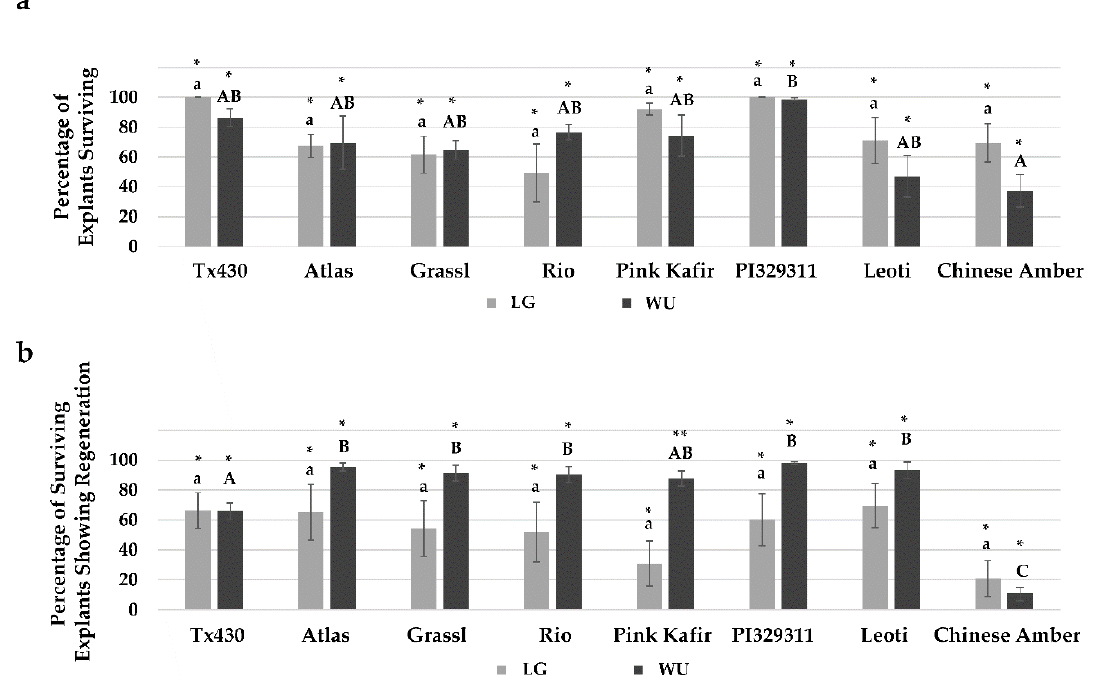
Figure 4. Impact of LG and WU protocols on overall explant response for the various genotypes. ( a ) Percentage of total initial explants surviving following eight weeks in culture. Results are plotted as the mean of three independent experiments (±SE). ( b ) Percentage of surviving explants exhibiting plantlet regeneration following eight weeks in culture. Results are plotted as the mean of three independent experiments (±SE). Data were analyzed by one-way ANOVA, and tested for significance using Tukey’s HSD Post-hoc Test. For comparisons across genotypes for the LG protocol, those with the same lowercase letter are not significantly different at p ≤ 0.05. For comparisons across genotypes for the WU protocol, those with the same uppercase letter are not significantly different at p ≤ 0.05. For comparisons across the two media within a genotype, those with the same asterisk pattern are not significantly different at p ≤ 0.05.